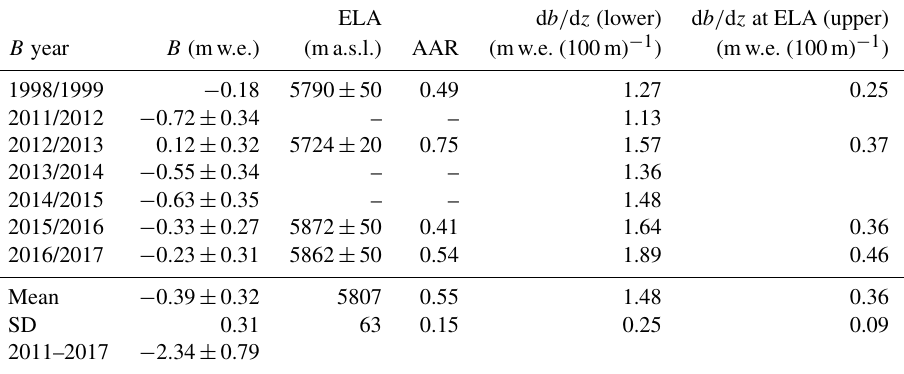
Table 3. Mass balance ( B ) measured with the glaciological method, ELA, AAR, and the lower and upper mass-balance gradients for Rikha Samba Glacier for the mass-balance years 1998/1999 and from 2011/2012 to 2016/2017. We did not calculate the ELA and AAR for 2011/2012, 2013/2014 and 2014/2015 due to the very few data points. For the mass-balance year 1998/1999, the point measurements collected by Fujita et al. (2001) were